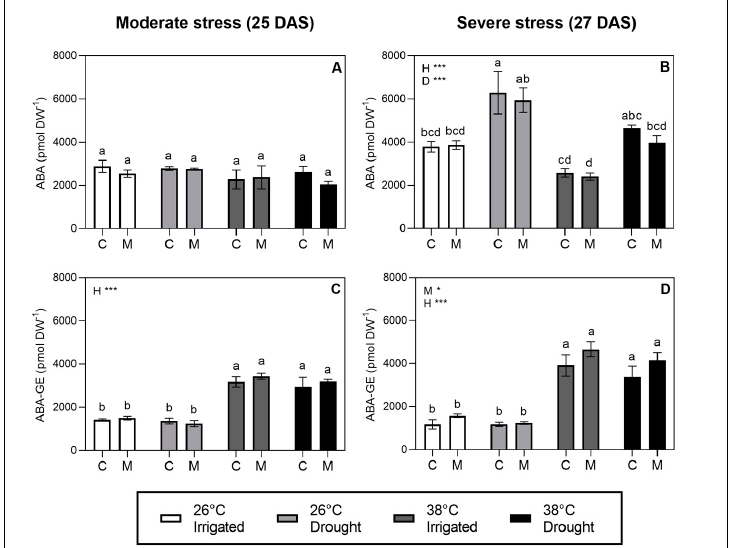
Figure 3. LC–MS analysis of ABA ( A , B ) and ABA-GE ( C , D ) performed on leaf material harvested during moderate stress (drought-stressed at SRWC ~50% and heat stress for 1 day) and severe stress (drought-stressed at SRWC ~20% and heat stress for 3 days). Values are mean ± SE. The effects of the three factors studied - heat stress (H), drought stress (D), melatonin treatment (M) - and their interaction are indicated in the left, upper corners of graphs. Significance levels are indicated by ***, p < 0.001; *, p < 0.05, whereas factors with no significant effect ( p > 0.05) are not listed. Lower-case letters on bars indicate differences between groups within each stress level significant at p < 0.05 in the post hoc multiple comparisons.